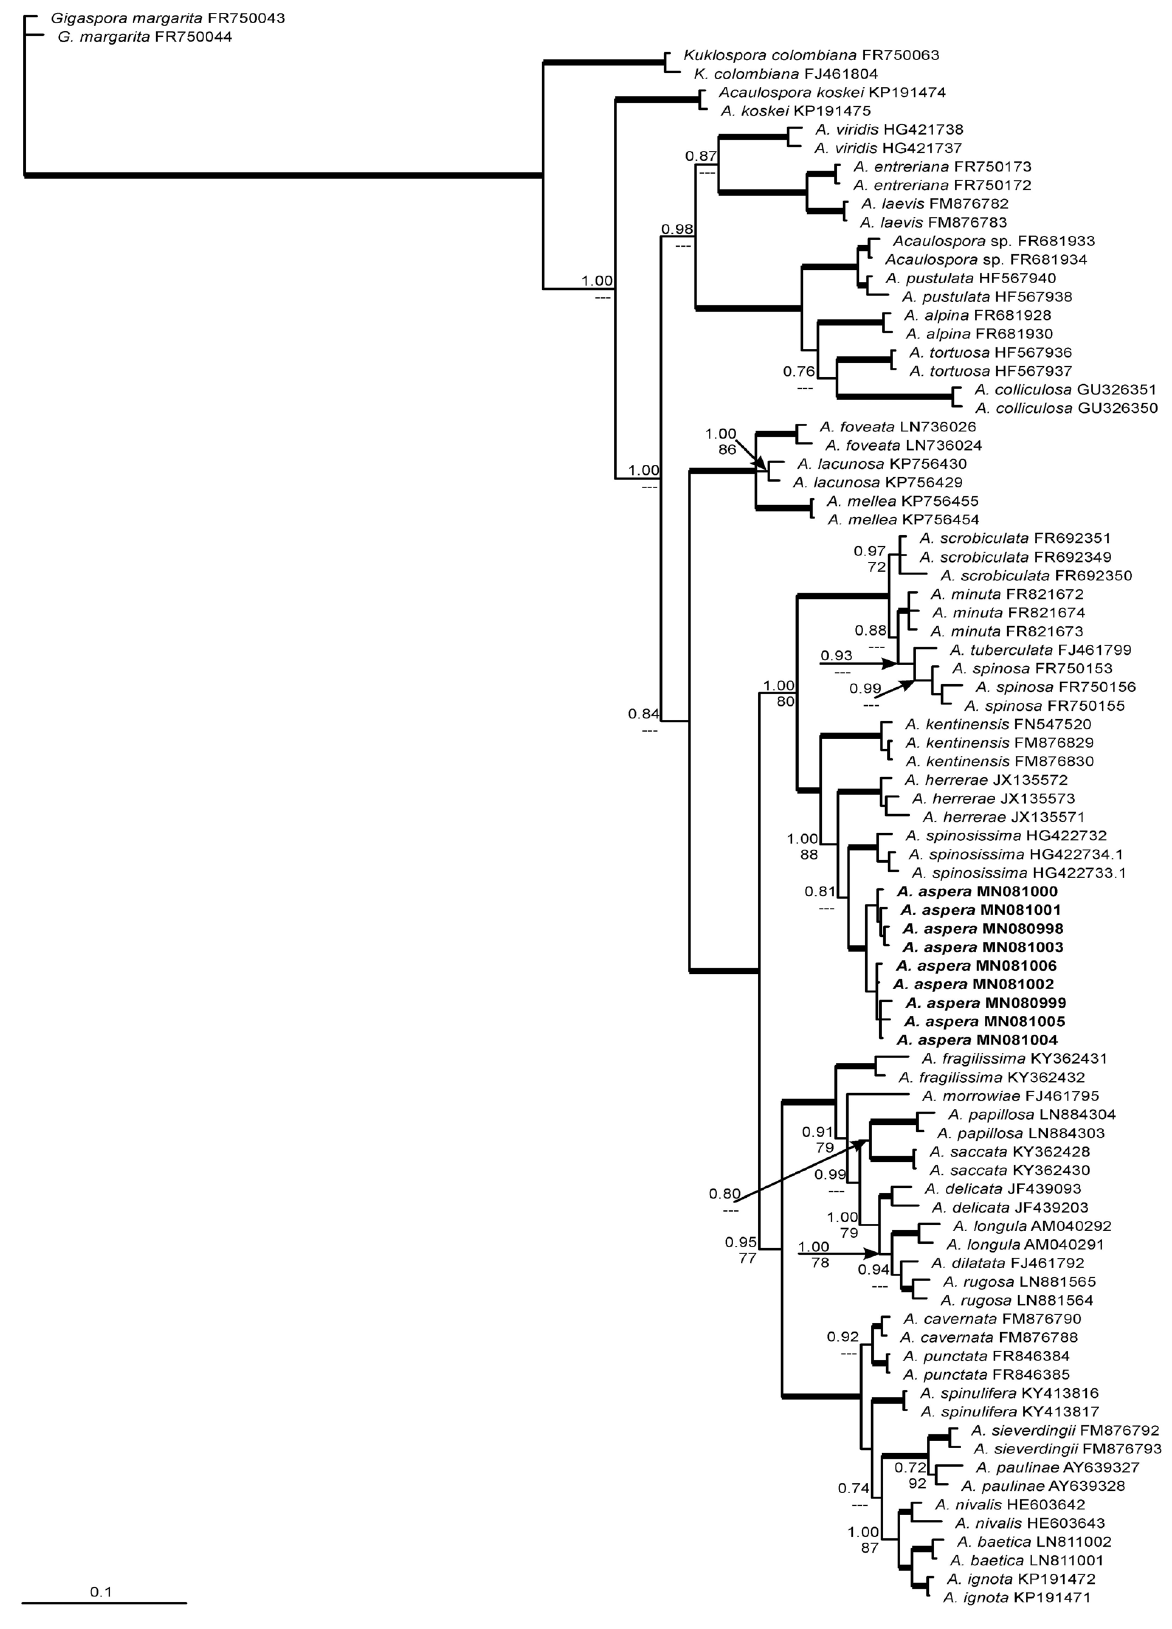
Fig. 19: Phylogenetic tree of the Acaulosporaceae obtained by analysis of partial SSU, 5.8S, and partial LSU rDNA sequences from different Acaulospora spp. Sequences are labeled with their database accession numbers. Support values (from top) are from Bayesian inference (BI) and maximum likelihood (ML), respectively. Sequences obtained in this study are in boldface. Only support values of at least 70% are shown. Thick branches represent clades with more than 90% of support in all analyses. The tree was rooted by Gigaspora margarita